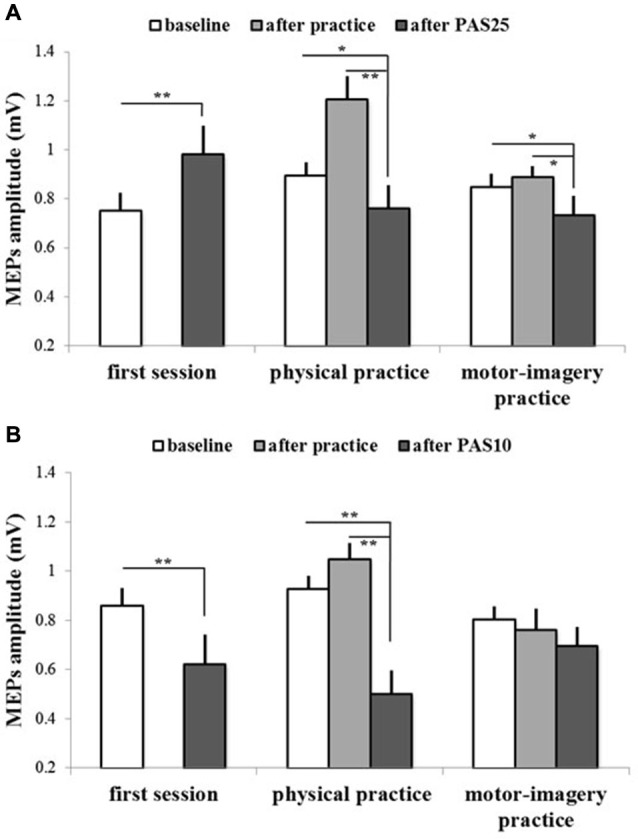
PAS effects on mean MEPs amplitude in different experimental sessions (first session, physical practice and motor-imagery practice) for both GROUPPAS25 (A) and GROUPPAS10 (B). Data obtained before and after practice and after PAS protocol administration are shown. Vertical bars indicate SE. Asterisks indicate significant difference between MEPs before PAS and MEPs after PAS when interaction of SESSION * TIME was statistically significant (*p < 0.05; **p < 0.01).